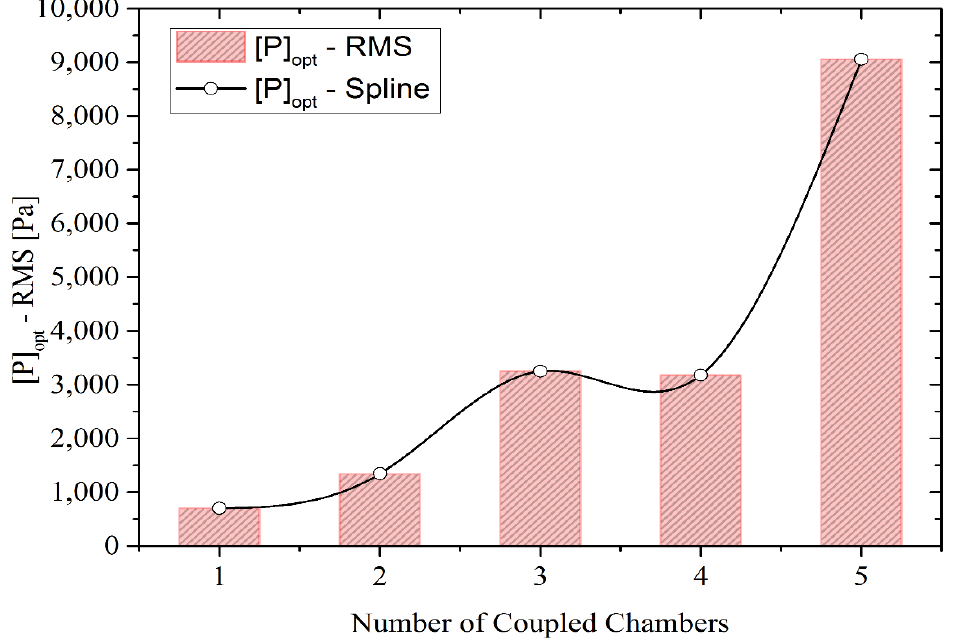
Figure 12. Pressure from the highest performing cases.